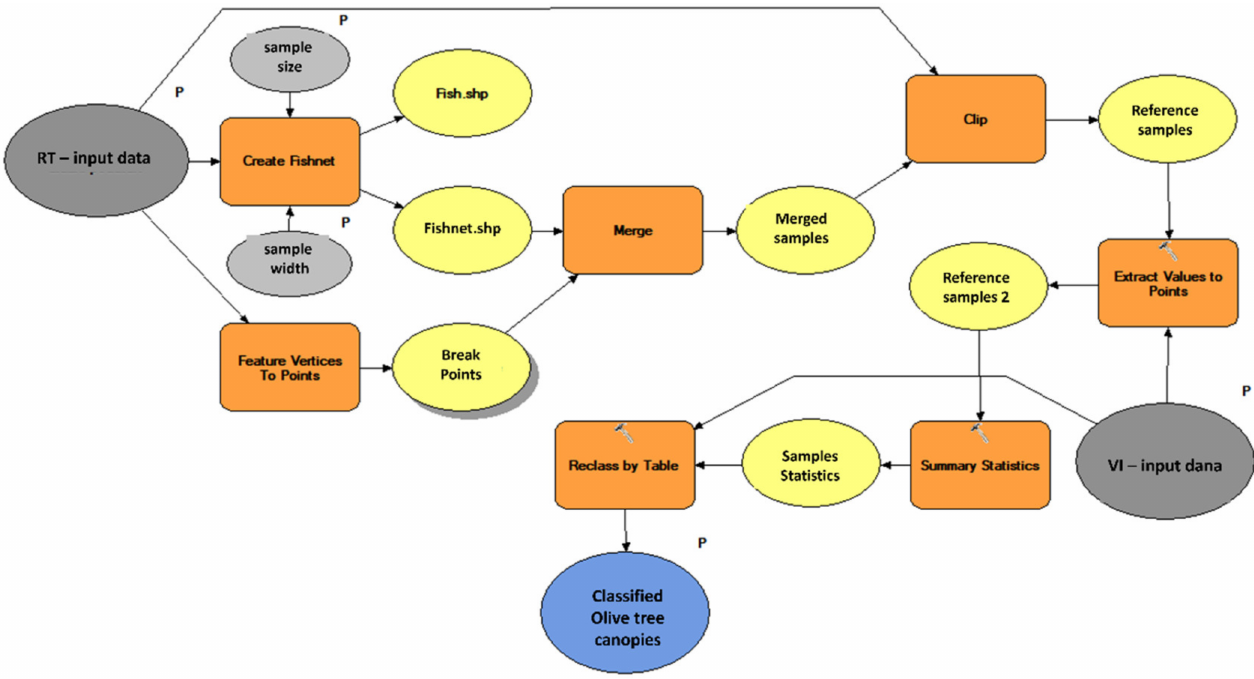
Figure 7. VITO tool